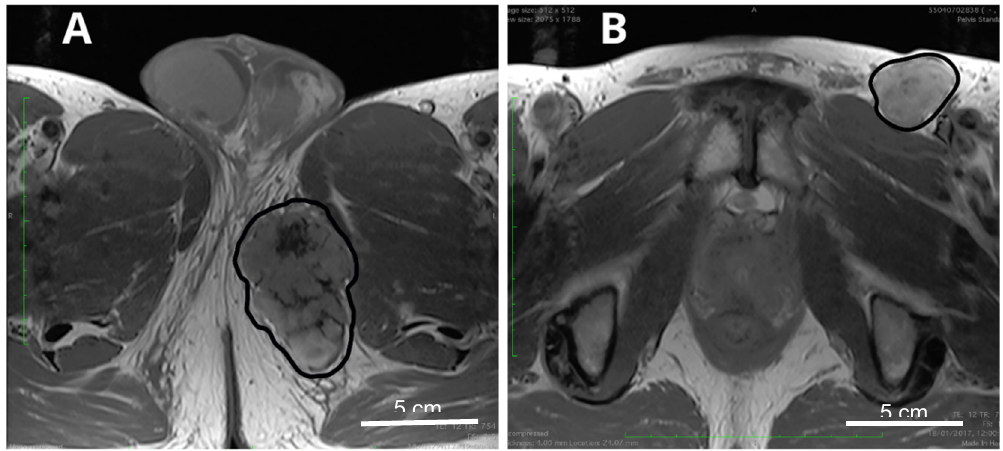
Figure 1. Epithelioid sarcoma—perineal area. ( A ) Locally advanced primary tumor (delineated, black contour); ( B ) Metastases to regional lymph nodes in the same patient (delineated, black contour).